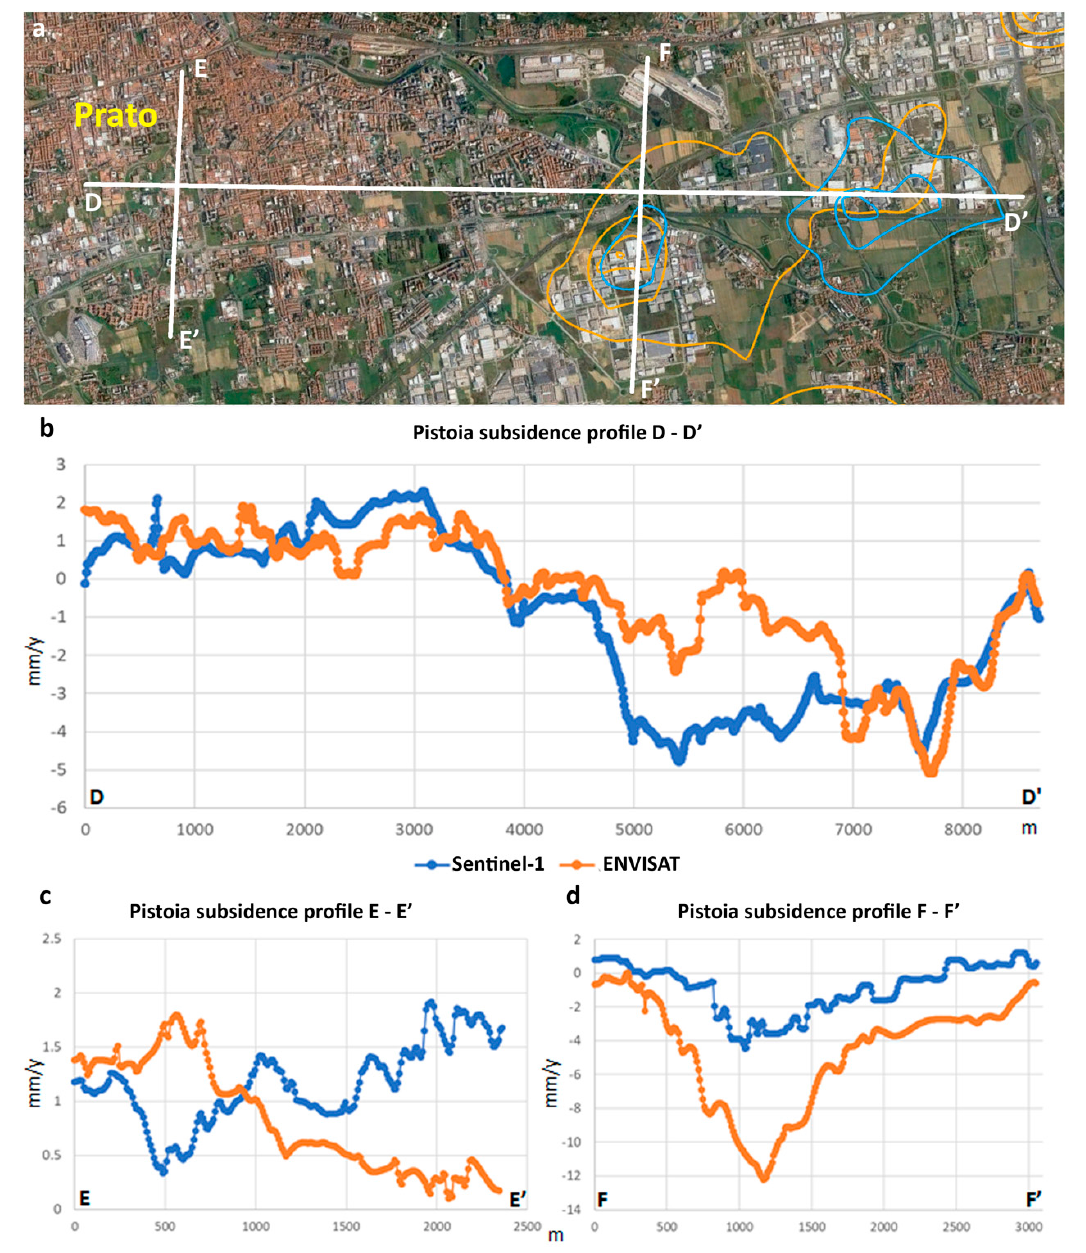
Figure 11. Subsidence line ( a ) cross sections of Prato. One N-S profile (D-D’, ( b )) and two E-W profiles (E-E’, ( c ), and F-F’, ( d )). ENVISAT data acquired from 2003 to 2010, Sentinel-1 data acquired from 2014 to 2017.